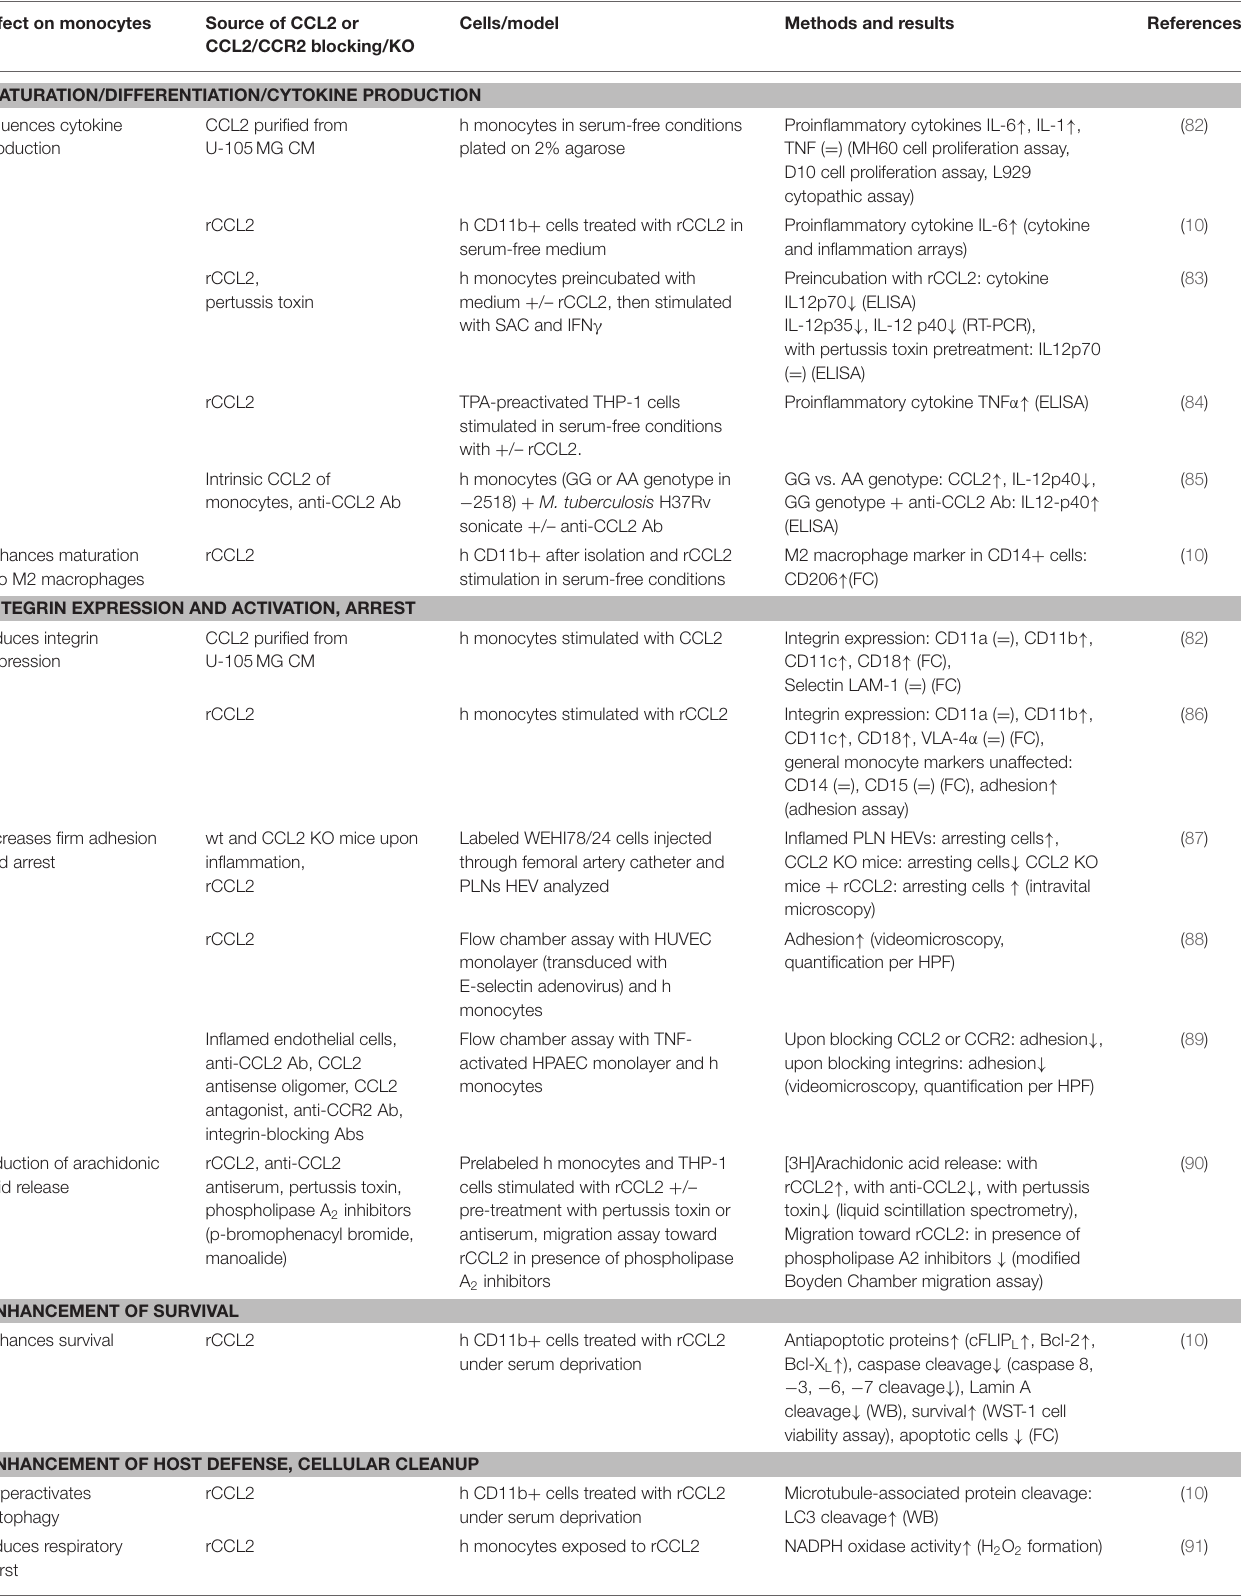
TABLE 2 | CCL2’s effects on